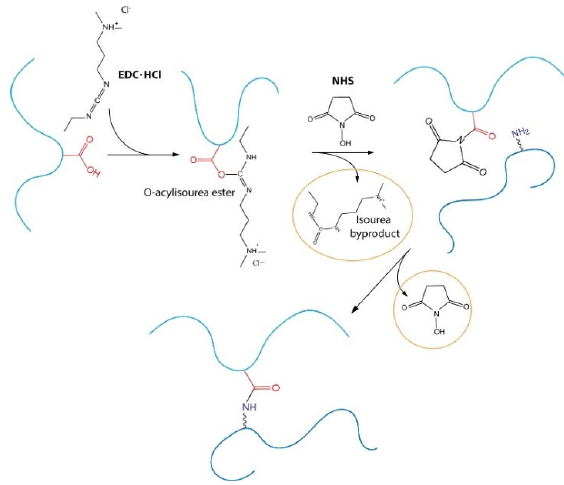
Figure 10. Reaction scheme of the crosslinking process.